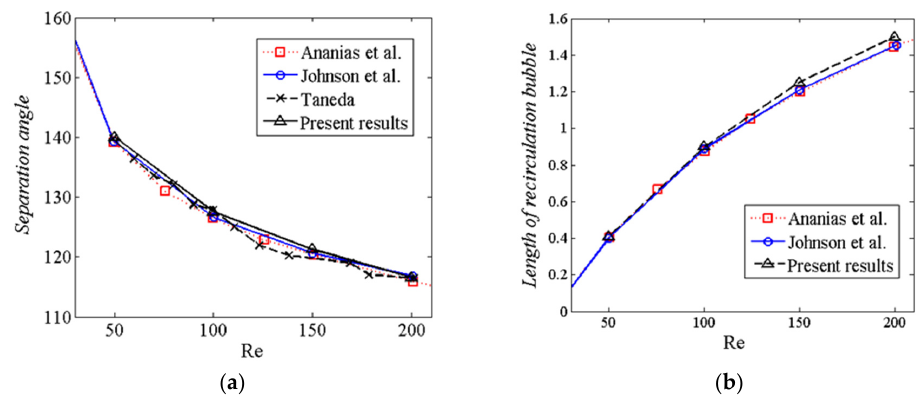
Figure 6. Wake structure versus Reynolds number: ( a ) separation angle; ( b ) bubble length.